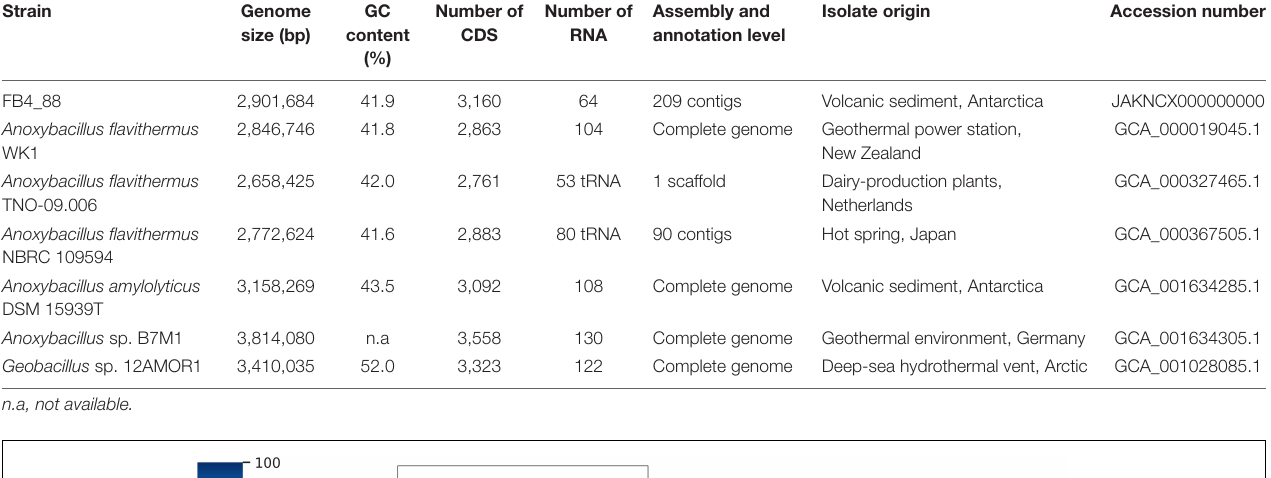
TABLE 3 | General features of the genome of Anoxybacillus FB4_88 and genomes of other members of Bacillaceae. Strain